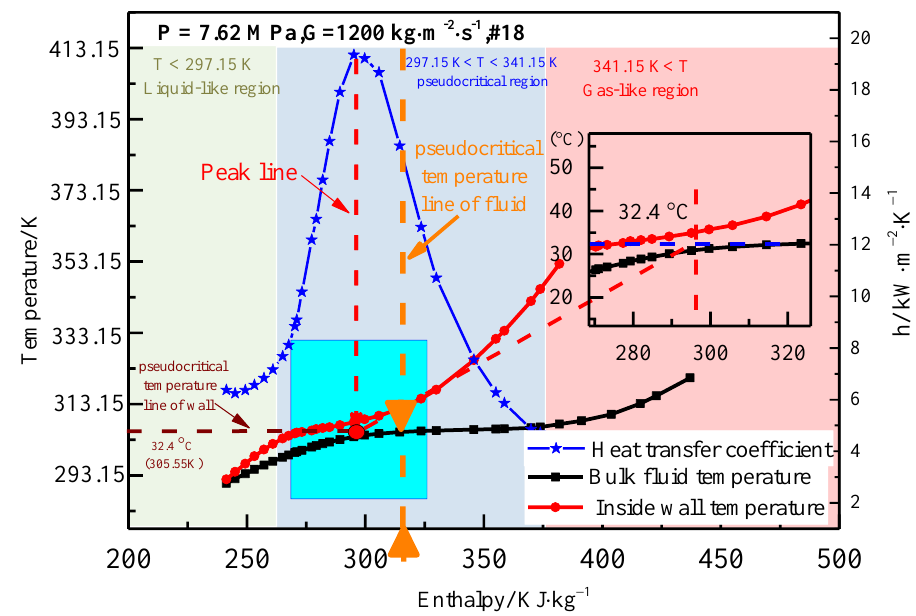
Figure 4. Basic characteristics of heat transfer in a vertical upward flow.